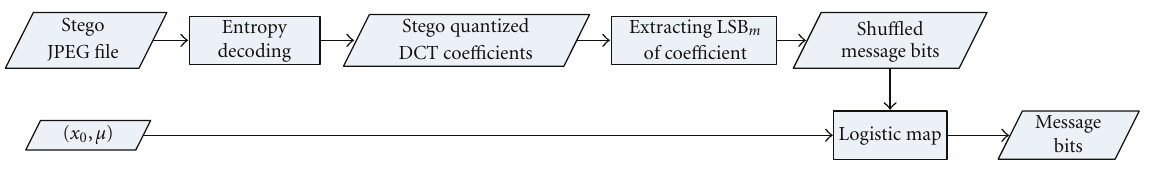
Figure 4: Extracting procedure of our proposed method.